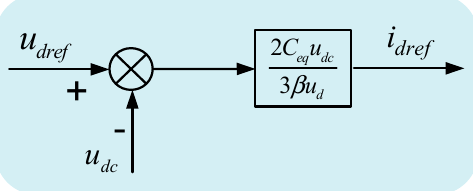
Figure 4. Structural block diagram of current outer loop sliding mode variable control strategy.